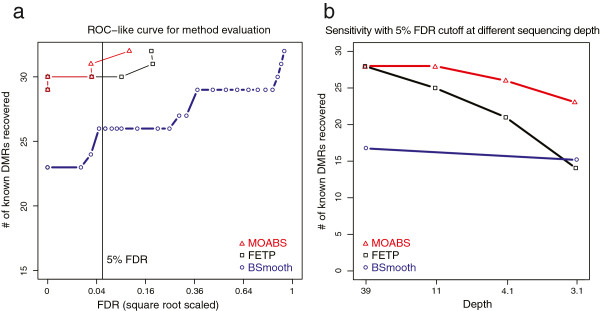
MOABS improves the detection of allele specific DNA methylation. (a) The y-axis shows the number of known DMRs recovered by three different methods. (b) Sensitivity (Y-axis) at 5% FDR with different sequencing depth (X-axis).